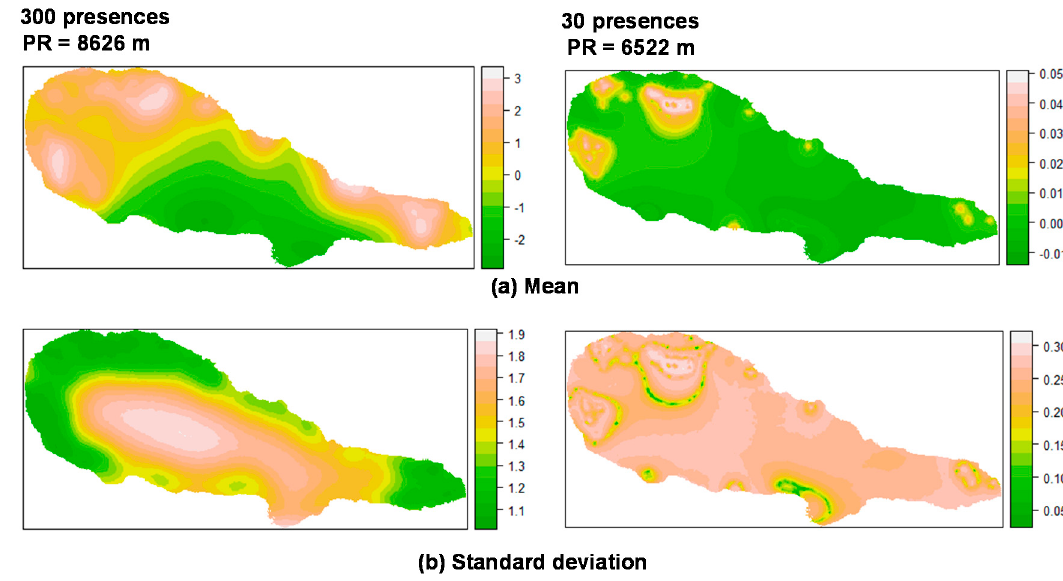
Figure 2. Summary of the spatial random effect (Gaussian random field) for the best mixed effects models and their reduction for M. faya in Pico Island. Mean ( a ); Standard deviation ( b ). PR: Practical range.